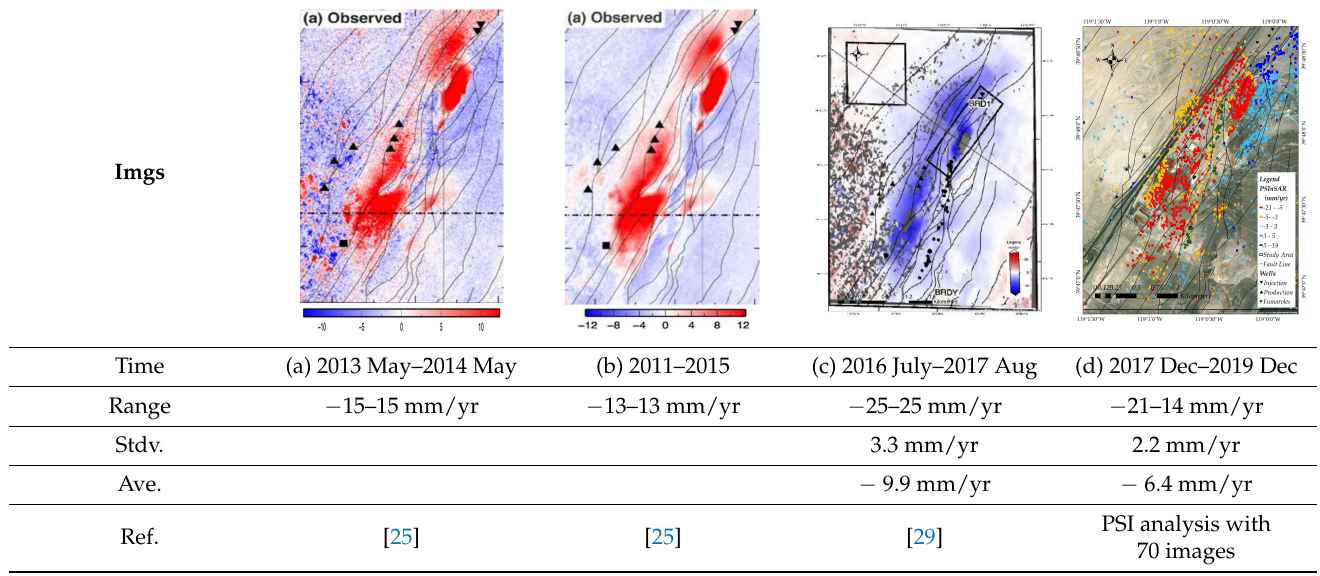
Table 5. Comparison of the previous studies with our analysis result (Imgs: Images – Stdv: Standard Deviation – Ave: Average – Ref: